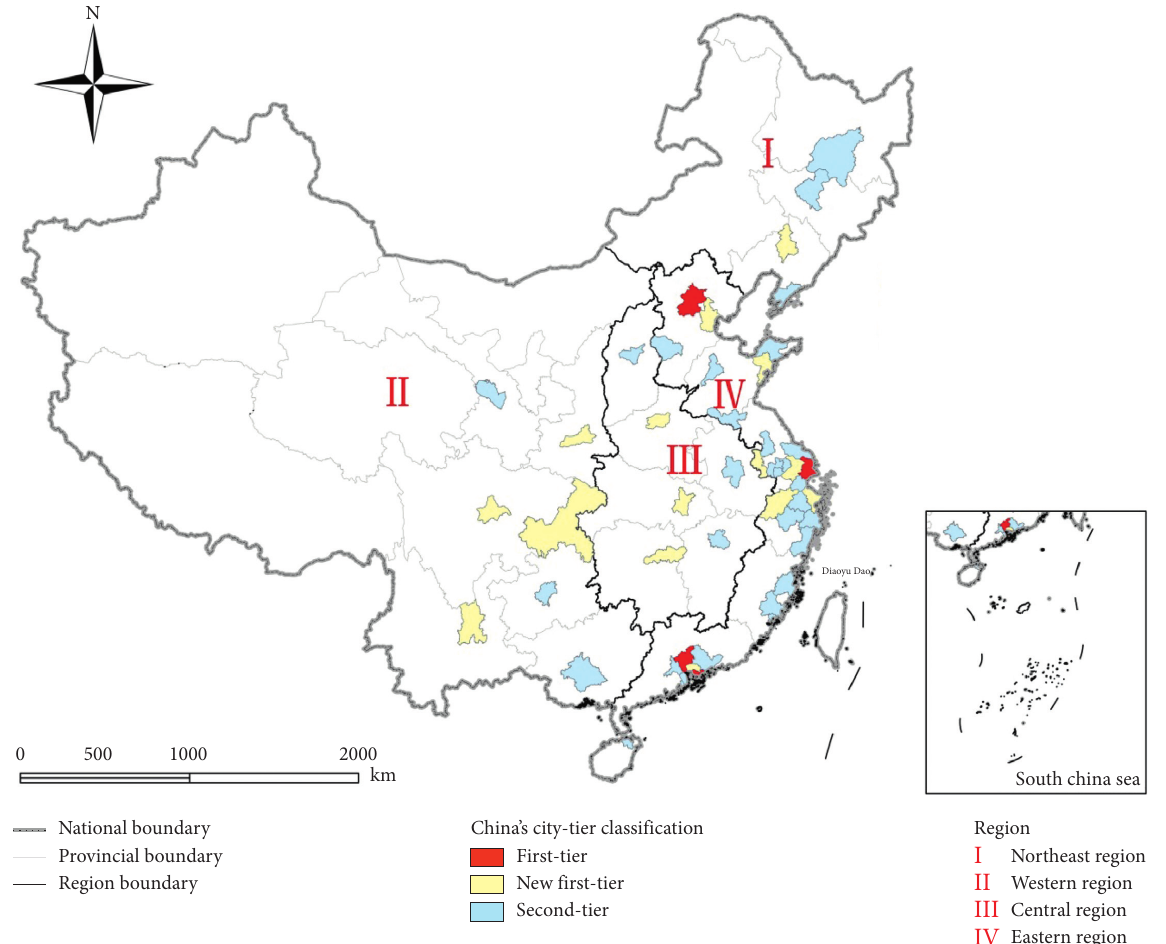
Figure 1: Location of the study